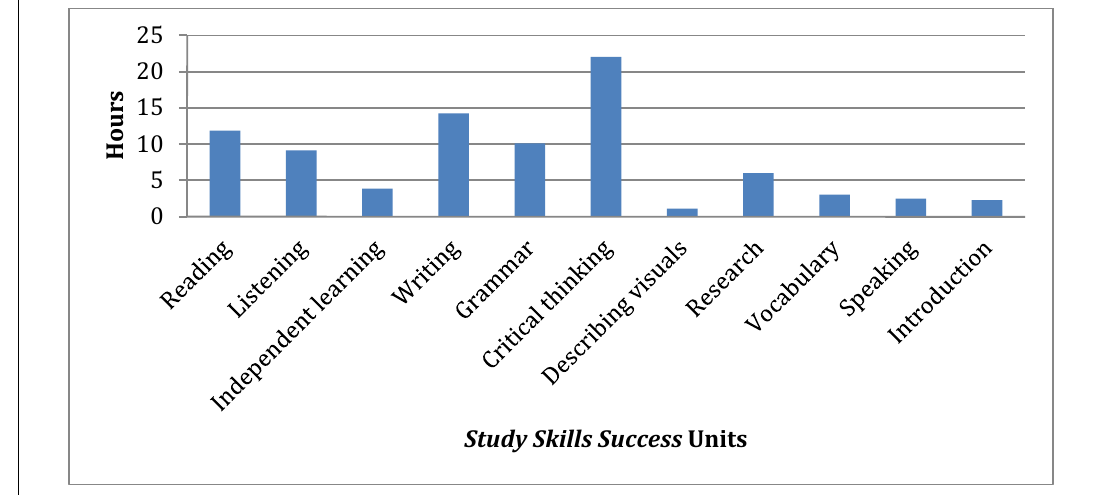
Figure 1: Program